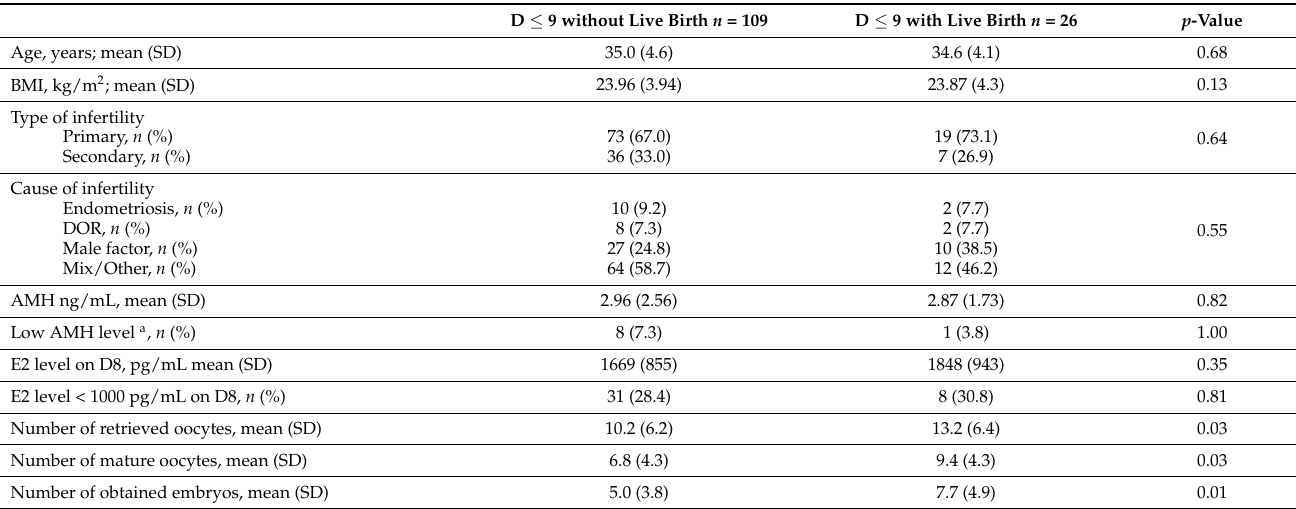
Table 3. Predictive factors of live births when ovulation trigger occurs by D ≤